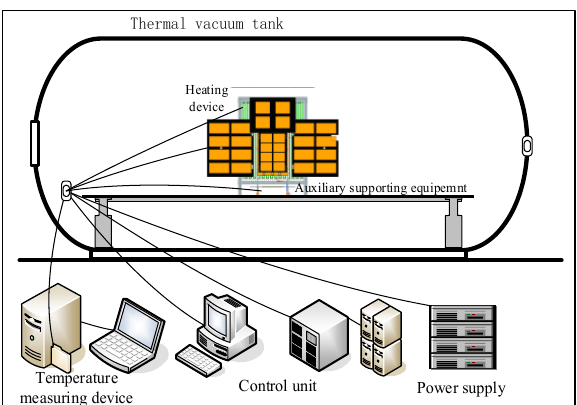
Figure 13. Schematic diagram of the testing devices.